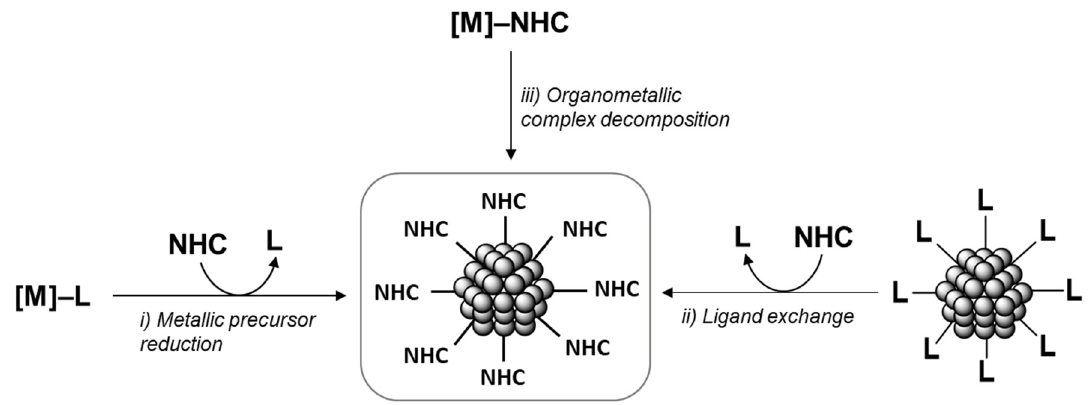
Scheme 2. Different synthesis methodologies for NHC ‐ stabilized